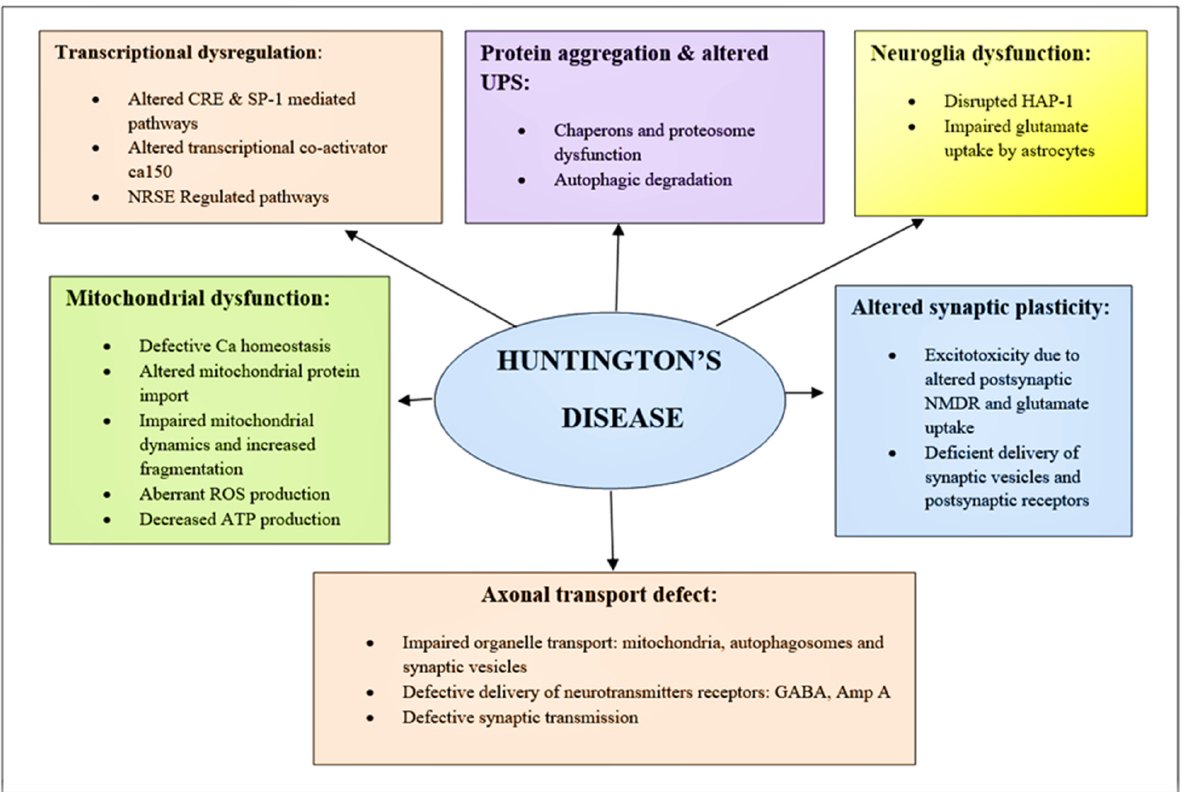
Figure 3. Schematic of diverging pathways leading to the pathogenesis of HD. Here is the mechanism of pathogenesis, paying particular attention to those that are related to promising therapeutic targets. BDNF, Brain-derived neurotrophic factor; ROS, reactive oxygen species; NMDAR, N-methyl-D- aspartate receptor; UPS, Ubiquitin-protease System; NRSE, Neuron restrictive silencer elements; CRE, cAMP response